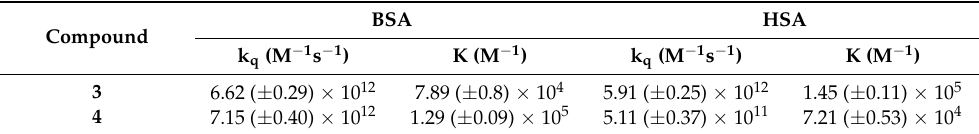
Table 5. Emission-quenching constants (k q ) and binding constants (K) for the interaction of 3 and 4 with BSA and HSA.